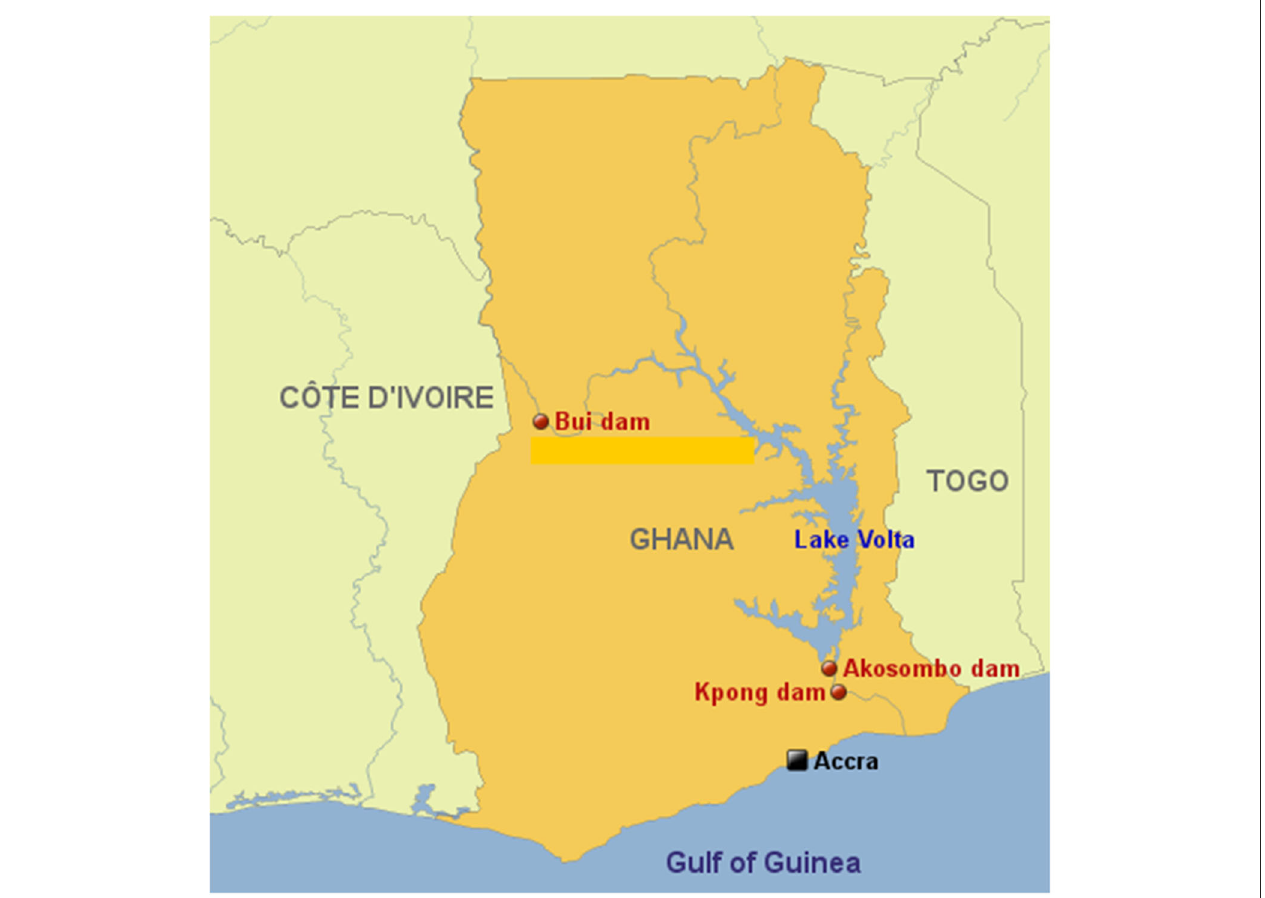
FIGURE 1 | Map of Ghana showing the Bui Dam location. Source: http://facultyexchangeghana.blogspot.com/2014/03/ghanas-infrastructure-electricity.html, March